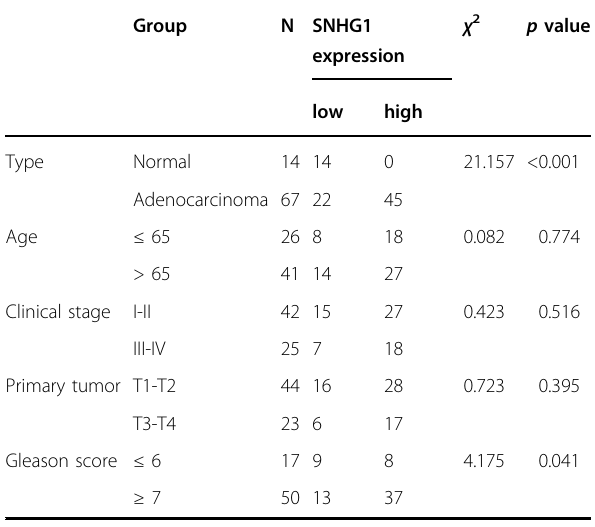
Table 1 Expression of SNHG1 in normal prostate tissues and prostate cancer